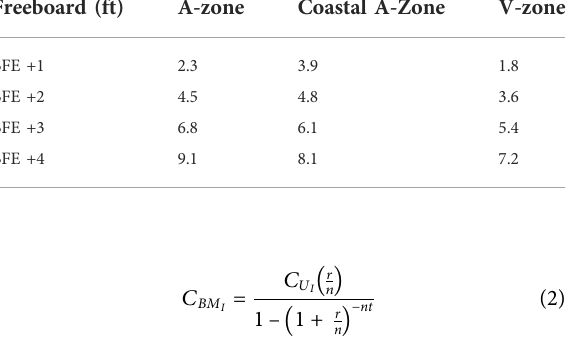
TABLE 1 Upper limit of mean cost of construction increase (%), by FEMA fl ood zone and freeboard (FEMA 2008). Freeboard (ft) A-zone Coastal